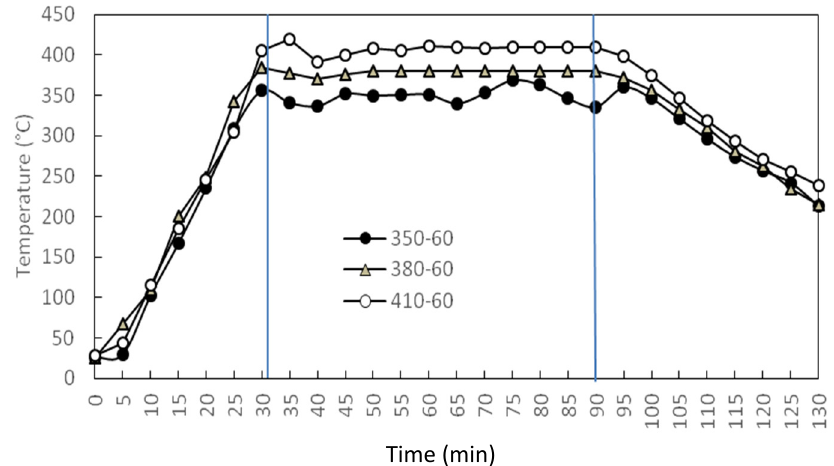
Figure 3. Time ( t ) variations of temperature ( T ) during heating, constant-temperature reaction and cooling for three T C . Retention time = 60 min; 350-60: T C in ◦ C- t in